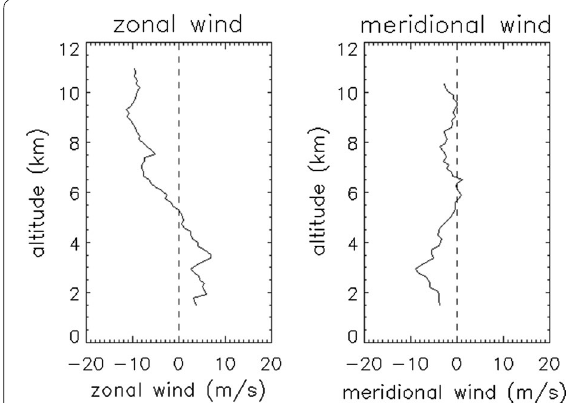
Fig. 7 Eastward (left) and northward (right) wind velocity profiles observed with EAR at 14:30 LT on May 31, 2016